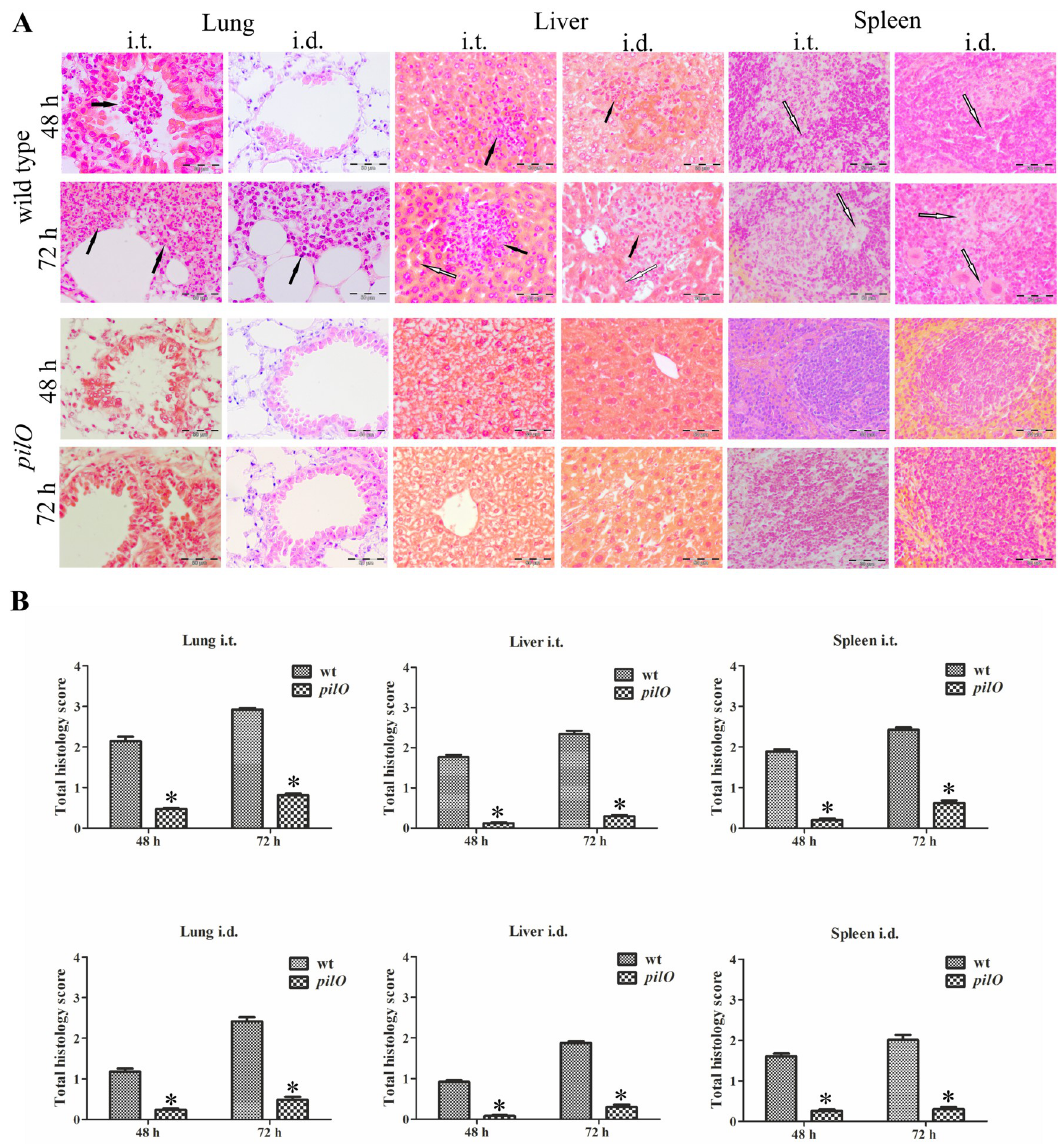
Fig 9. Histopathology of mouse organs infected with F . novicida . Mice, three per group, were infected via the intratracheal (i.t.) or intradermal (i.d.) route using wt F . novicida or the pilO mutant. At 2 h, 24 h, 48 h and 72 h after infection, tissue sections from lungs, liver and spleen were stained with H&E and analysed by light microscopy (A) . Representative images of twenty microscopic fields were taken for each sample. Black arrows point the presence of inflammatory infiltrates, while white arrows indicate the destruction of parenchyma. Histopathology scoring of lungs, liver and spleen tissue (B) . Twenty high-powered fields were randomly chosen to grade the severity of inflammation as well as the overall damage of organs parenchyma. The histology assessment consists of grading the presence of inflammatory infiltrates and affected parenchyma. Lung tissue was scored for infiltration of mononuclear cells and alveolar and bronchial involvement, liver tissue was scored for hepatocyte vacuolation and the presence of inflammatory infiltrates, while the spleen tissue was scored for overall destruction of architecture of red pulp, white pulp and capsule. The total histology score of each organ was calculated as an average of individual criteria scores (0-absent, 1-slight, 2-moderate, 3-severe). The error bars show the standard deviations. Asterisks denote that the histopathology scoring of the pilO mutant is statistically different from that of wt F . novicida , as determined by Student t- test ( � , p <